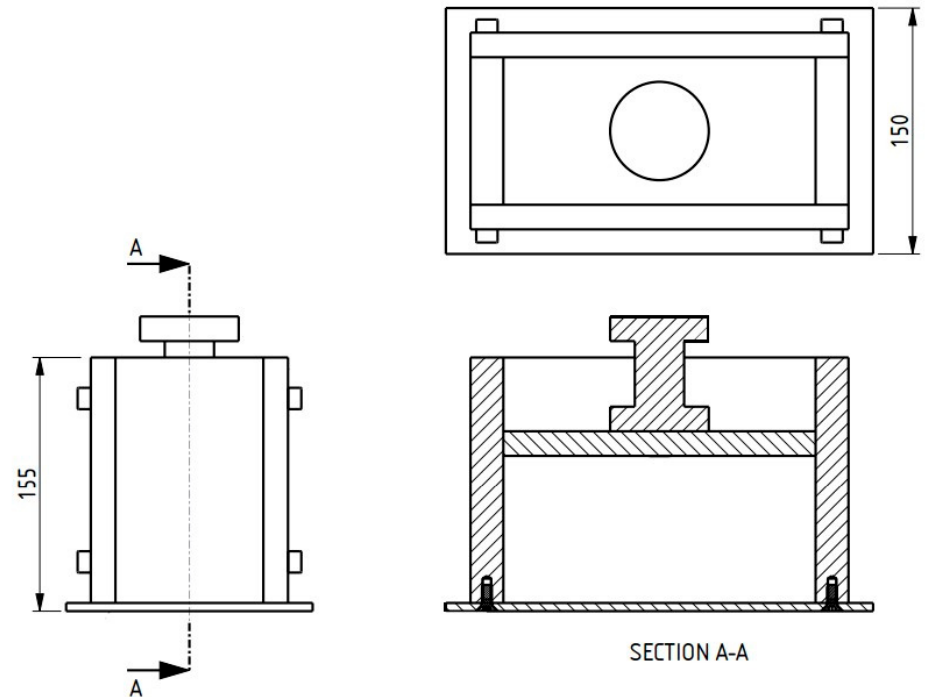
Figure 1. Mould design.